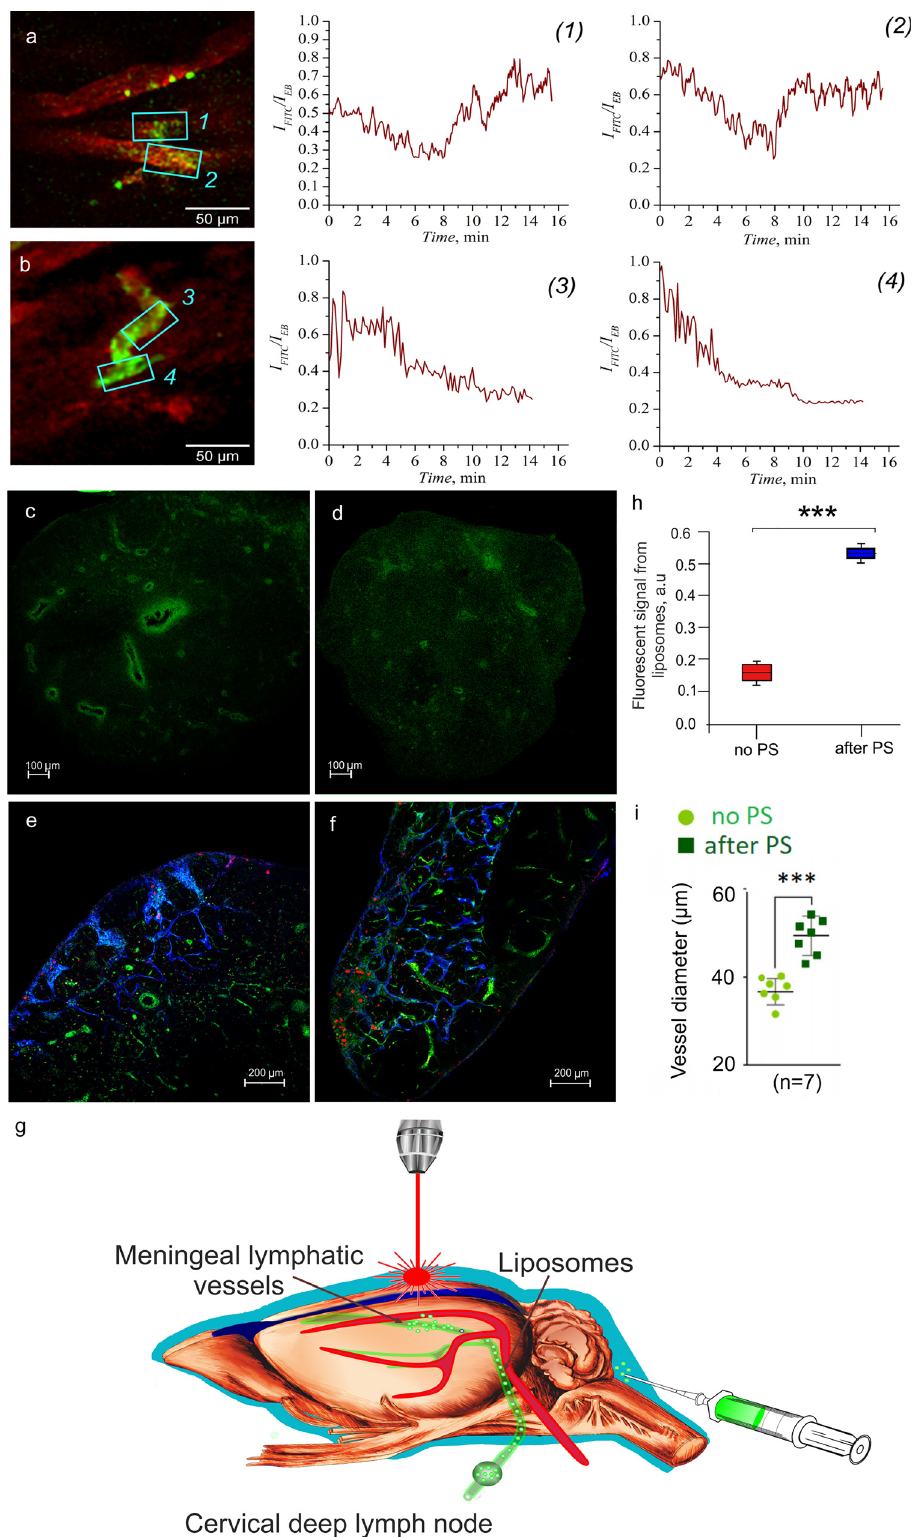
Figure 4: The photostimulation of lymphatic clearance of liposomes from the brain: a and b – Real-time confocal images and kinetics of the fl uorescent signal intensity (1 – 4) from liposomes in the cervical LVs after their injection into the cisterna magna in the PS-treated (a) and the untreated (b) groups. Blue rectangles denote regions of interest (ROIs) used to measure the averaged intensity of fl uorescence (1 – 4);